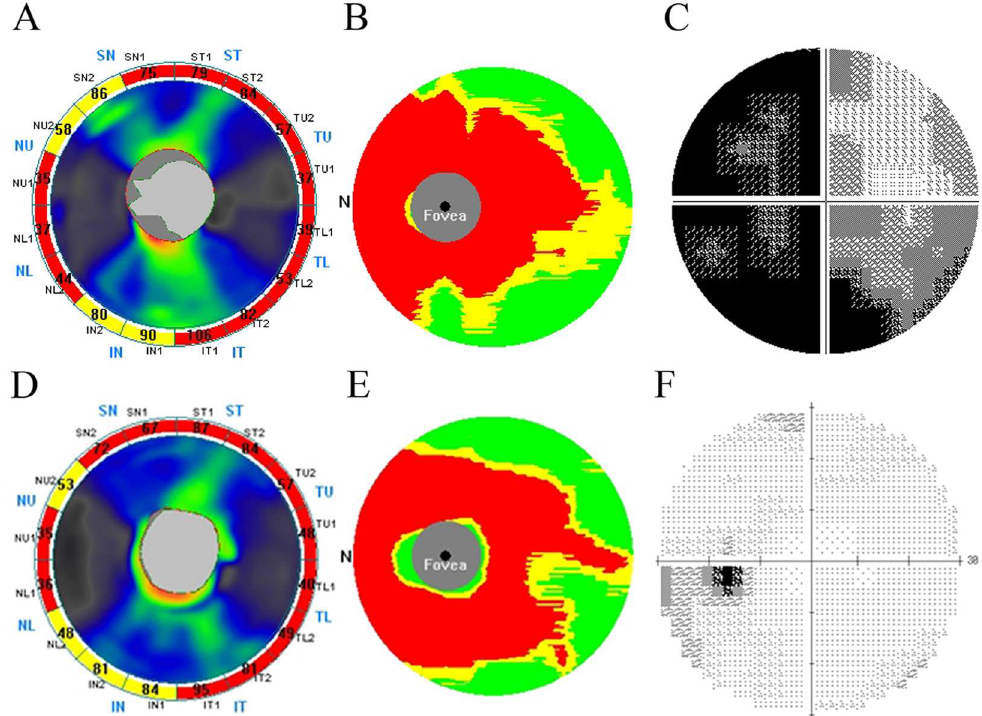
Fig 1. Representative cases of aquaporin-4 antibody (AQP4 Ab)-positive (A − C) and -negative (D − F) optic neuritis in the left eye. Shownare optic nerve headmaps (A, D) and GCC significancemaps (B, E) from RTVue optical coherence tomography analyses, and gray scales (C, F) of Humphrey visual field 30–2tests. Tests were conducted6.5 years and 4.5 years after the latest onset of optic neuritis in the seropositive and negativecase, respectively.